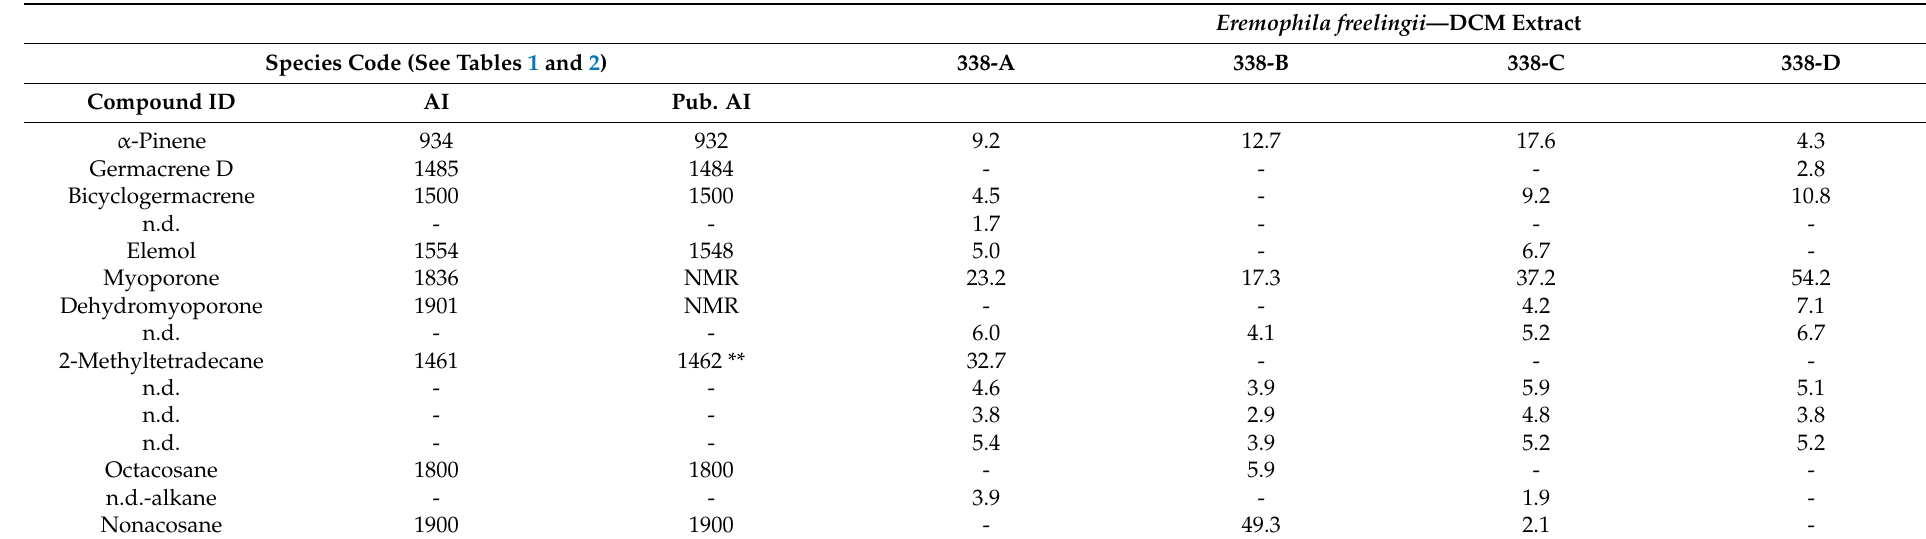
Table 5. Chemistry of solvent extract volatiles from Eremophila freelingii